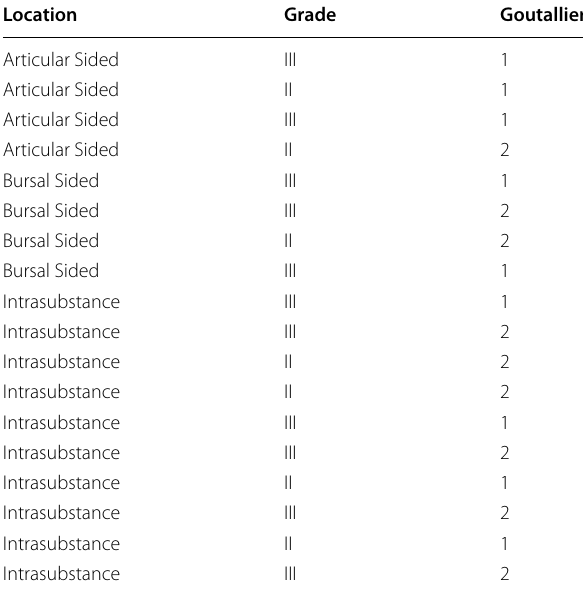
Table 1 Characteristics of the partial‑thickness tears according to Ellman and Goutallier classifications